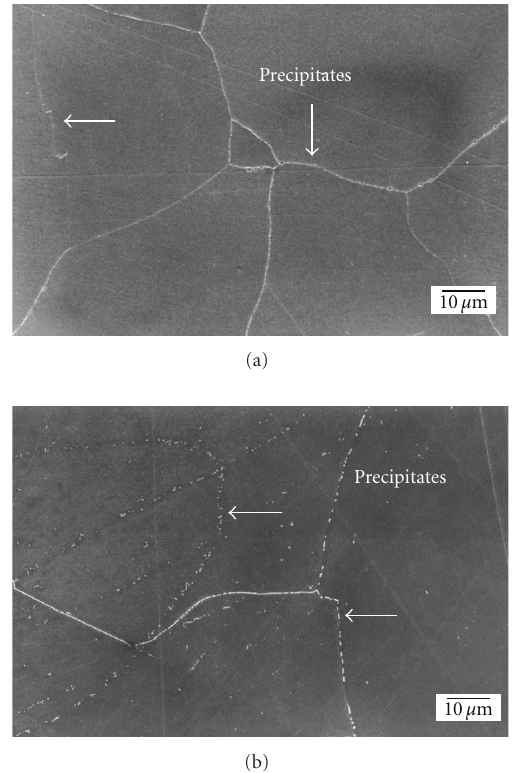
Figure 1: SEM micrographs the (a) JN1 and (b) JJ1 steels aged at 1073 K for 500 min.